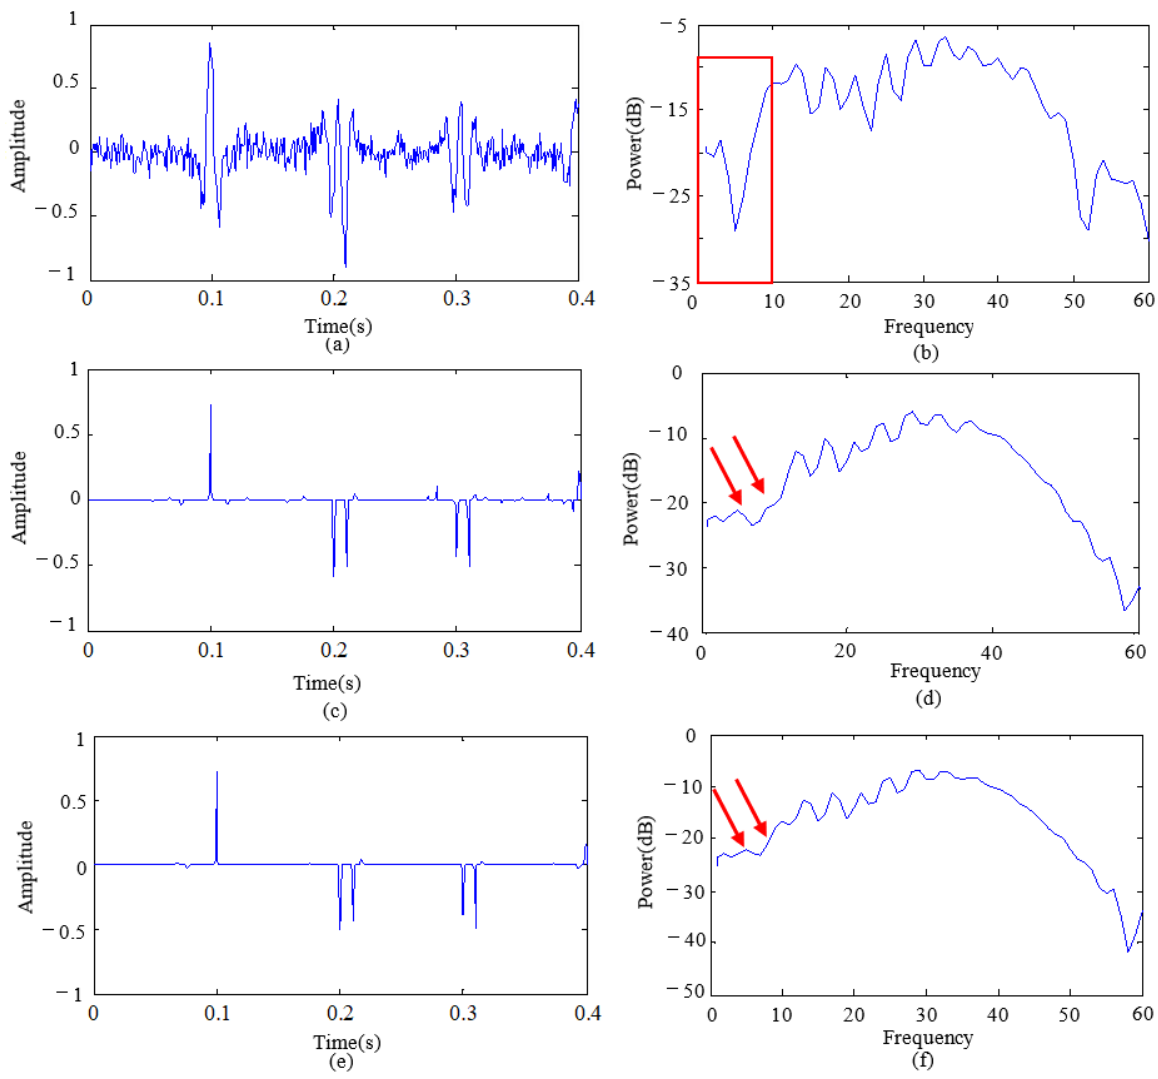
Figure 8. Comparisons of low-frequency expansion when SNR = 5.10. ( a , b ) Noisy data and their frequency spectrum, ( c , d ) reflection coefficients estimated by CS and extended spectrum, ( e , f ) reflection coefficients estimated by proposed method and extended spectrum.